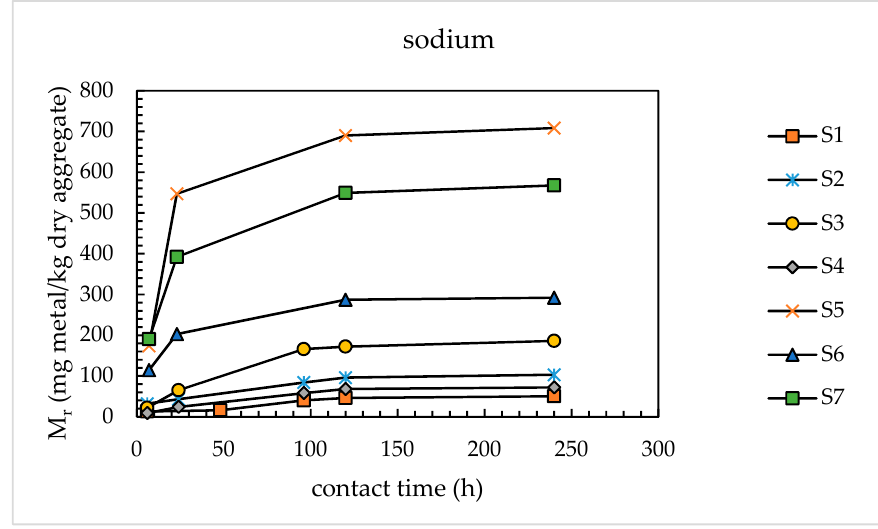
Figure 5. Effect of contact time on sodium release from sands S1–S7.